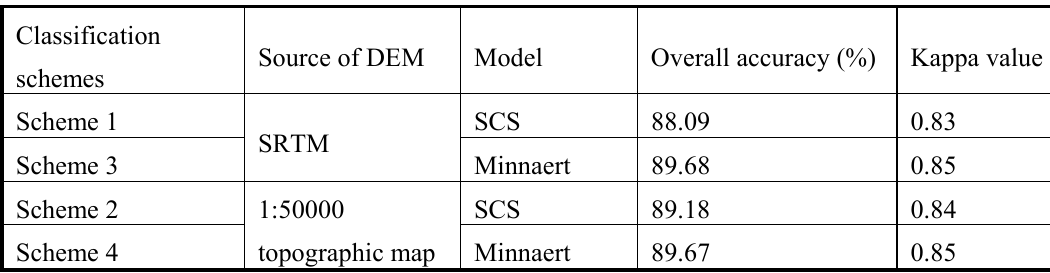
Table 6. Comparison of the accuracy assessments of LULC classification after different topographic corrections based on different spatial resolution